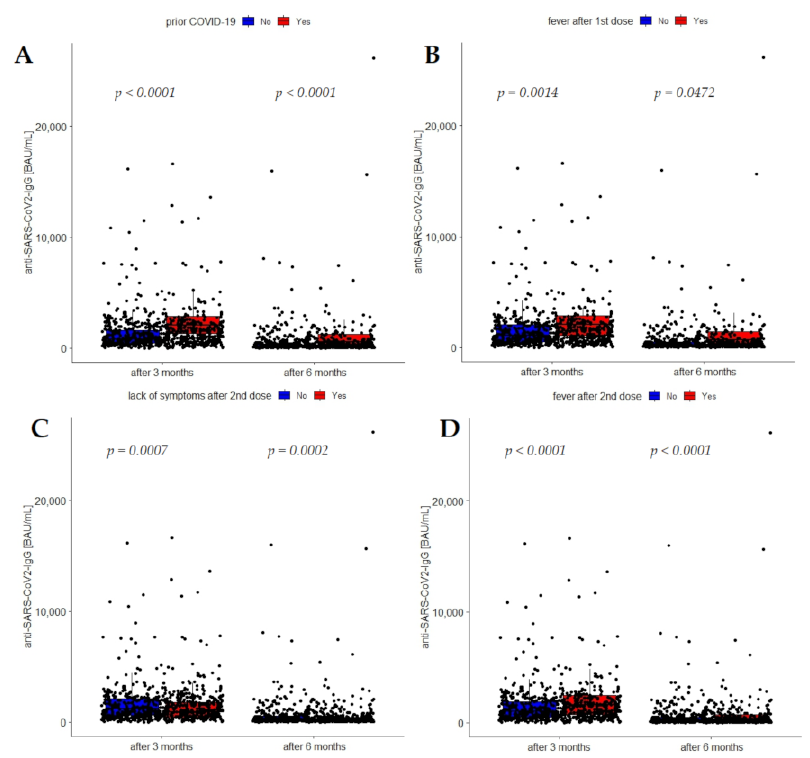
Figure 3. Anti-SARS-CoV-2 IgG concentrations 3 and 6 months after vaccination with regard to ( A ) prior-COVID-19 infection, ( B ) lack of symptoms after the second dose of the vaccine, ( C ) fever after the first dose of the vaccine, and ( D ) fever after the second dose of the